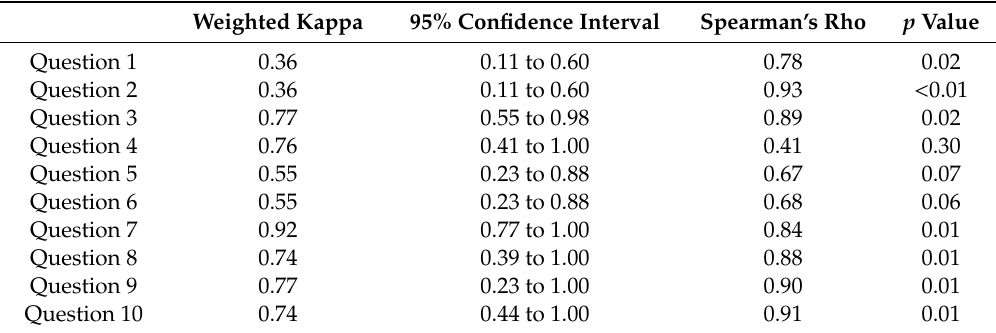
Table 2. Reliability of the survey